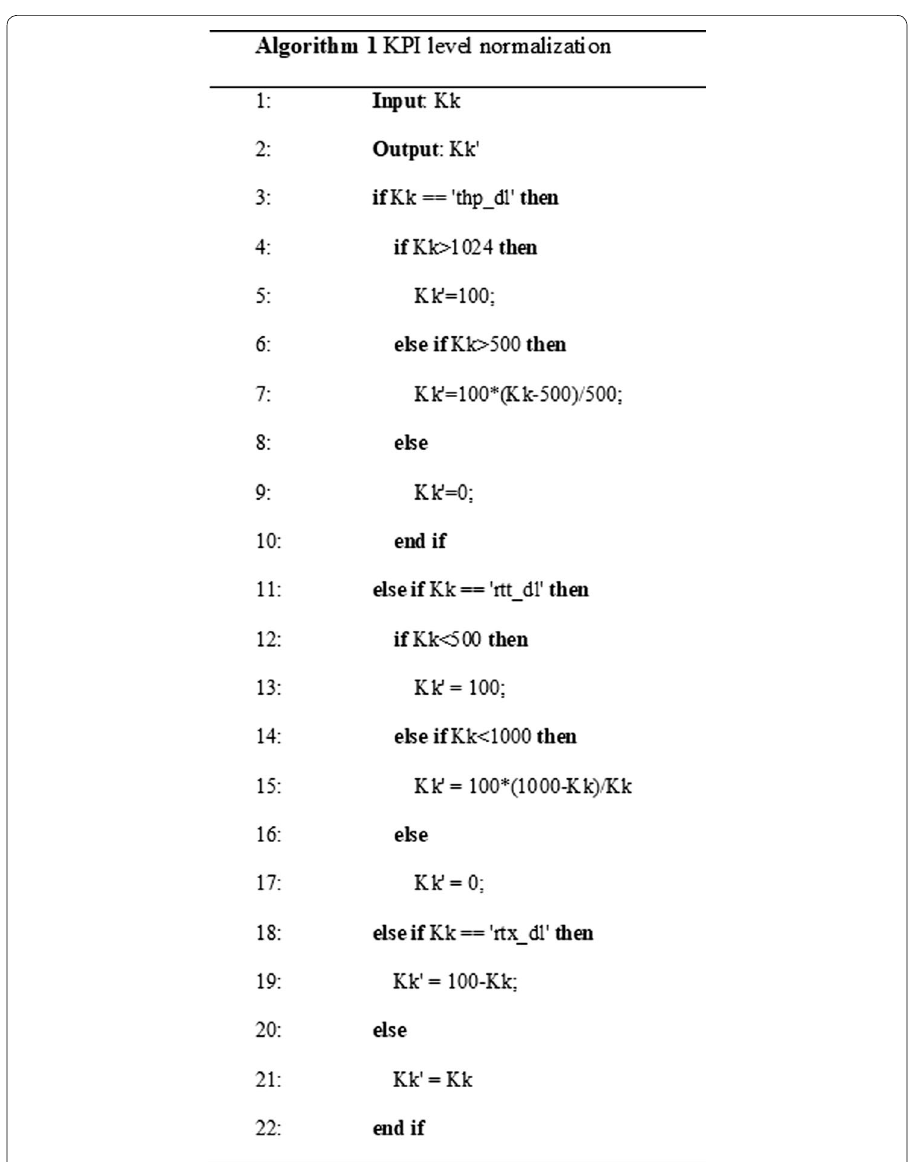
Fig. 3 Algorithm 1 for KPI level normalization: To normalize all the values of KPIs to be between 0 and 100, Algorithm 1 sets the lower and the upper boundaries of each KPIs depending of the threshold for the best and worst values. This was applied for the throughput downlink (thp_dl) in Kbps, the round-trip time on the downlink (rtt_dl) in milliseconds and the retransmission on the downlink (rtx_dl) in